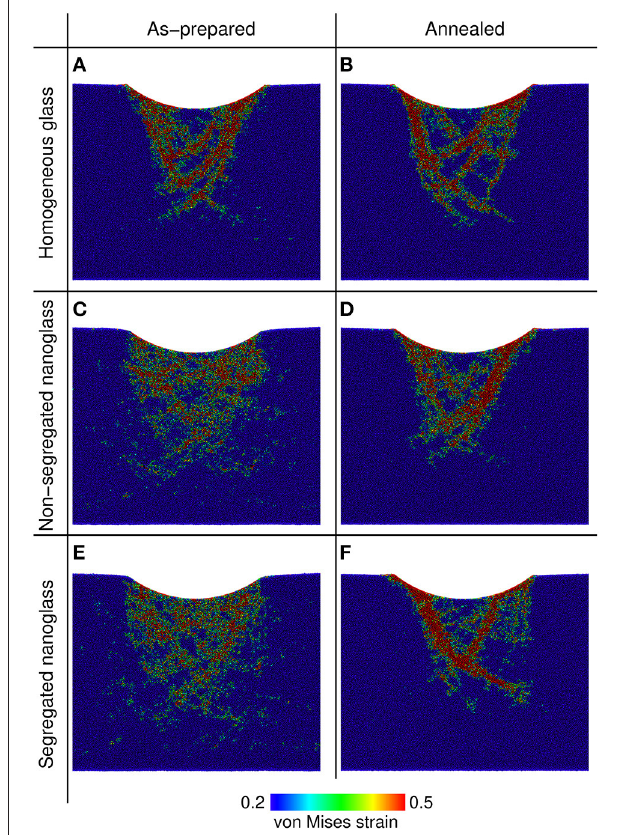
FIGURE 5 | Local atomic von Mises shear strain at indentation depth of 5 nm for (C,E) as-prepared and (D,F) annealed Cu64Zr36 non-segregated and segregated nanoglasses, as well (A) as-prepared and (B) annealed homogeneous glasses with identical chemical